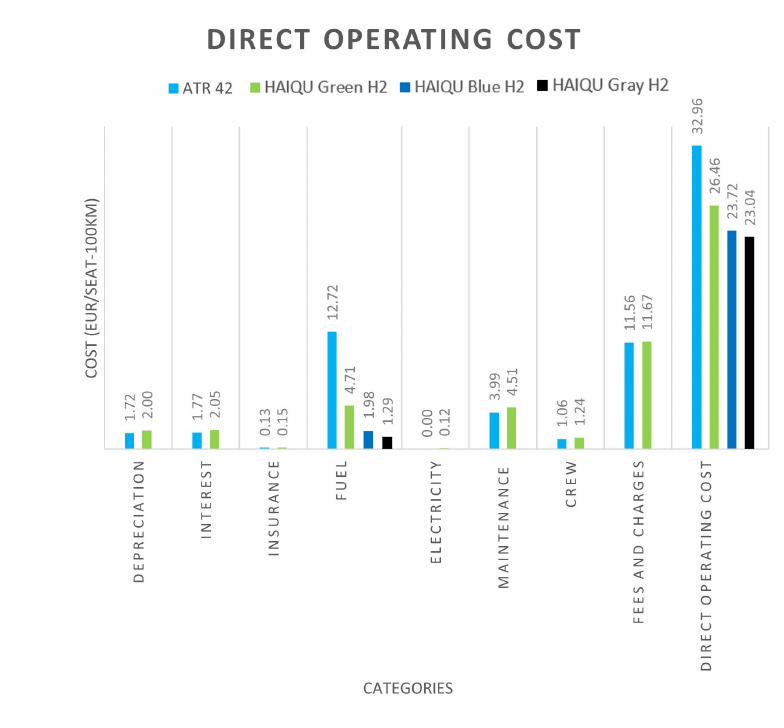
Figure 13. Cost for design mission for HAIQU based on 1500 flights per year. Table 14. Turnaround process